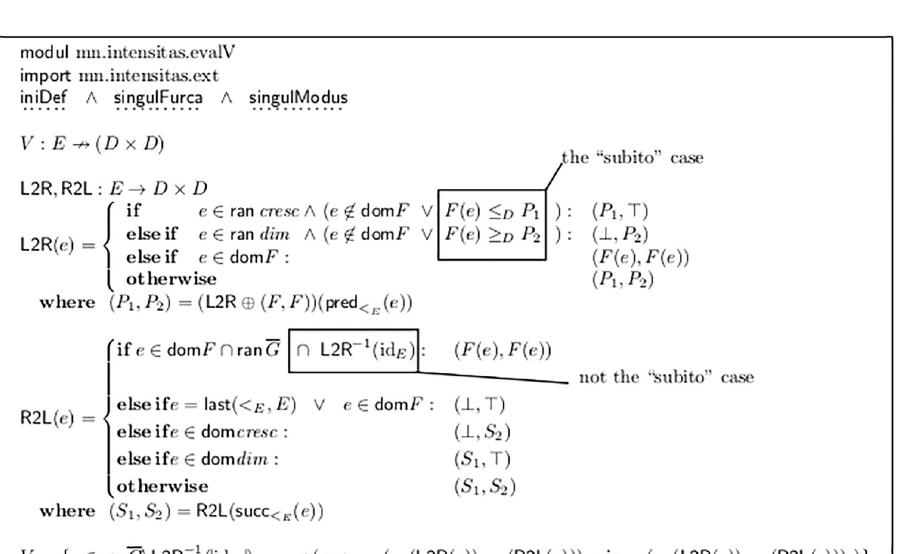
Fig 7. V-Analysis of fork ends,